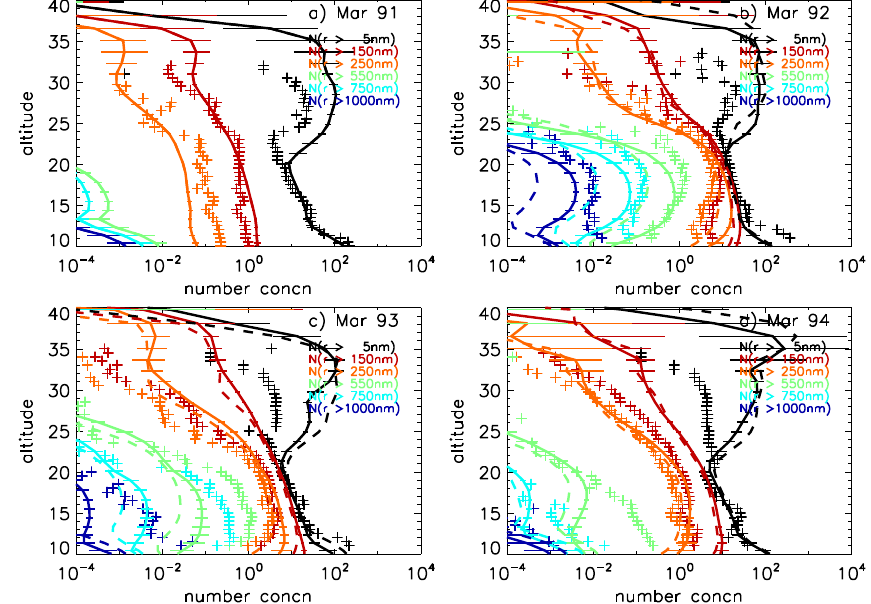
Figure 10. Same as Fig. 9 but for March 1991, March 1992, March 1993 and March